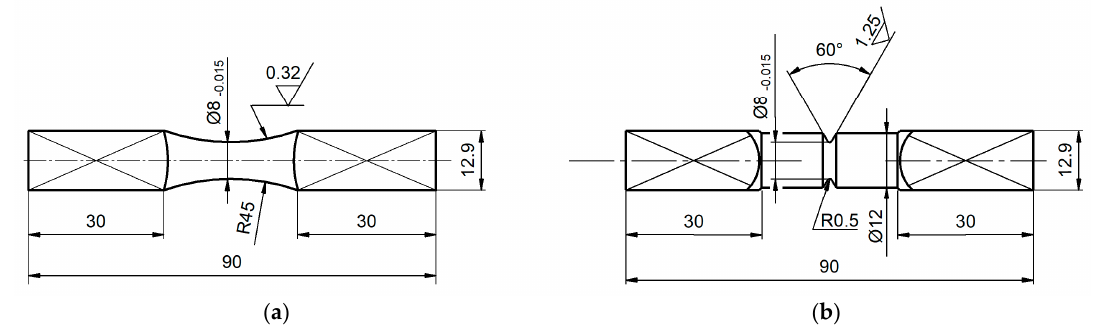
Figure 1. Shapes and dimensions of specimens: ( a ) smooth, ( b ) notched.